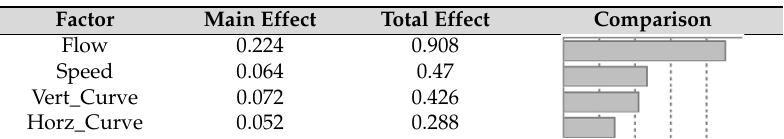
Table 5. Factors Association with the